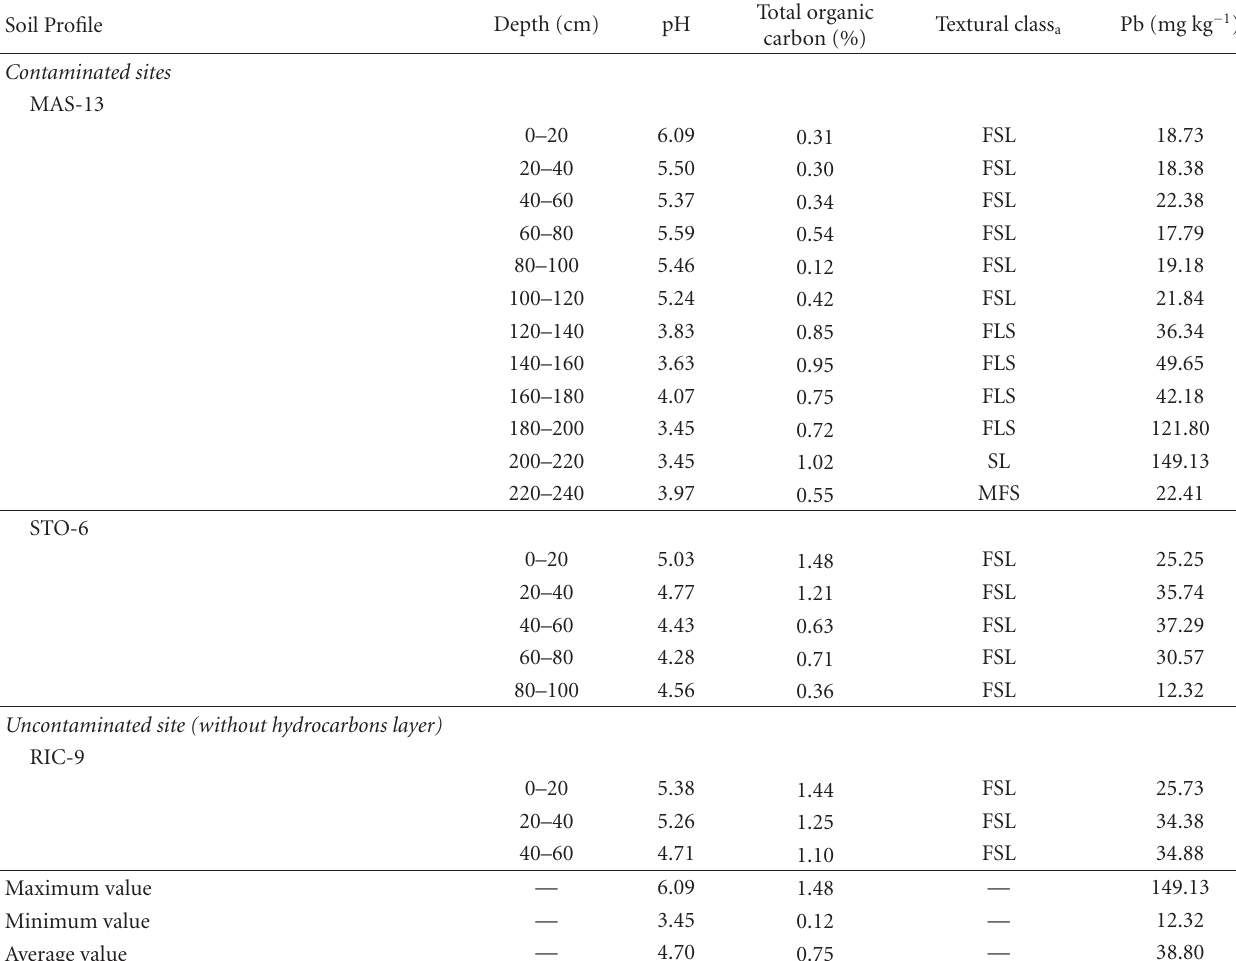
Table 2: Soil properties and lead concentrations in soil samples collected at contamined sites (MAS-13, STO-6) and uncontaminated site